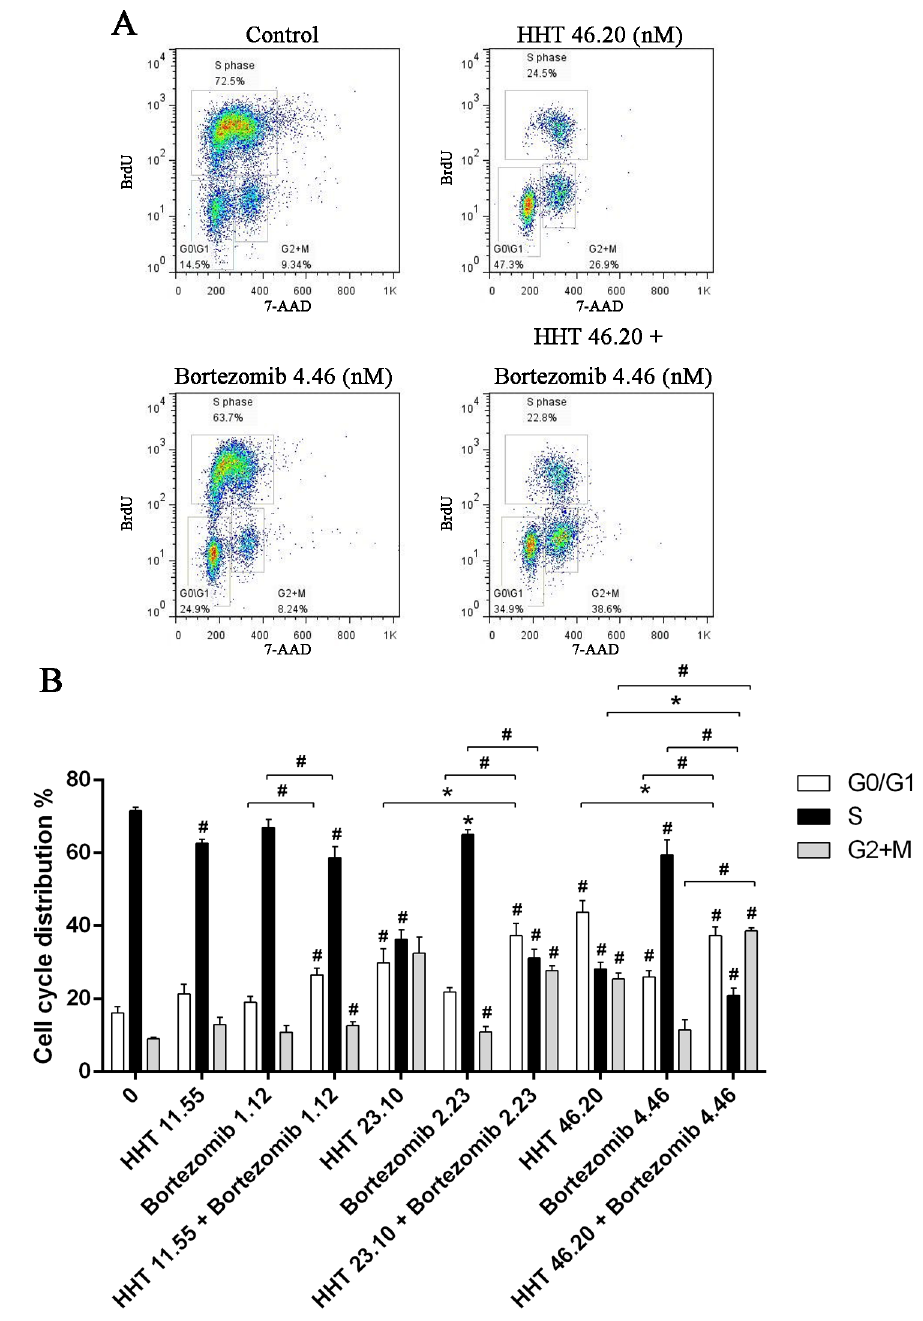
Fig 3. Simultaneous exposure to HHT and Bortezomib resulted in cell cycle arrest. (A) SKM-1 cells treated with 46.20 nM HHT, 4.46 nM Bortezomib or 46.20 nM HHT + 4.46 nM Bortezomib simultaneously for 72 h. (B) SKM-1 cells treated with HHT (11.55, 23.10, 46.20 nM) or Bortezomib (1.12, 2.23, 4.46 nM) for 72 h. Concurrently, simultaneous treatment experiments were conducted at molar ratio of 10.4: 1. Bar graph of cell cycle distribution. * P < 0.05, #P < 0.01 vs untreated